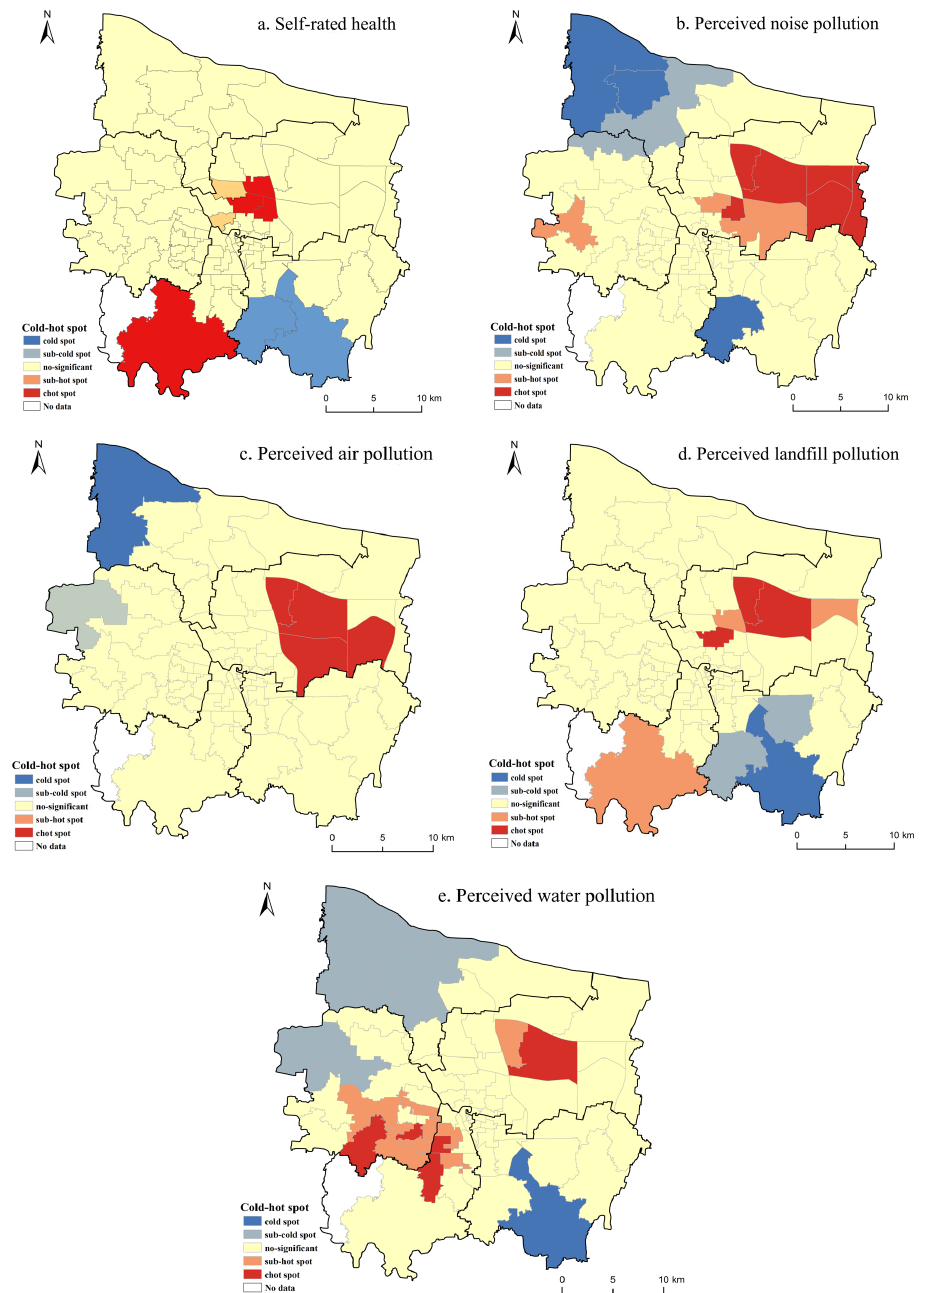
Figure 6. The cold–hot spot patterns of self-rated health ( a ) and four perceived environmental haz- ards ( b – e ) at the subdistrict (jiedao) level of Zhengzhou City. ( b – e ) at the subdistrict (jiedao) level of Zhengzhou